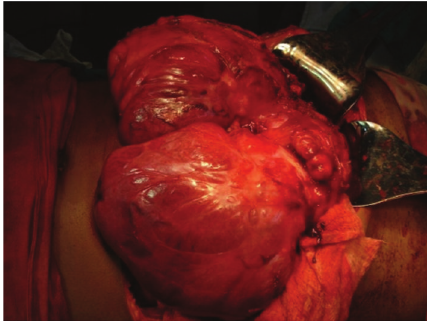
Figure 2: Intraoperative finding: bilobed, exophytic mass.